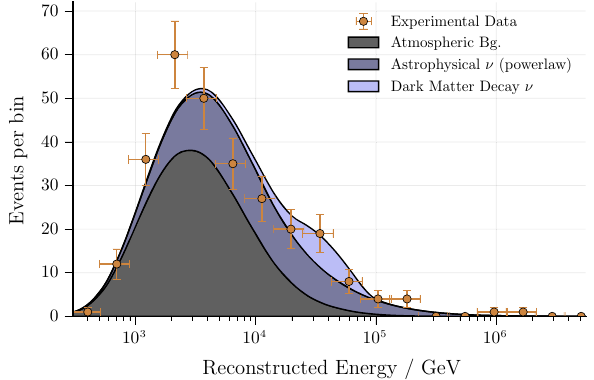
Fig. 3 Cascade analysis: best-fit energy distribution for the signal hypothesis (components stacked to illustrate the dark matter compo- nent), with the best fit parameters listed in Table 2. The fit is performed on un-binned data, but for visualization purposes a binning is applied in the figure